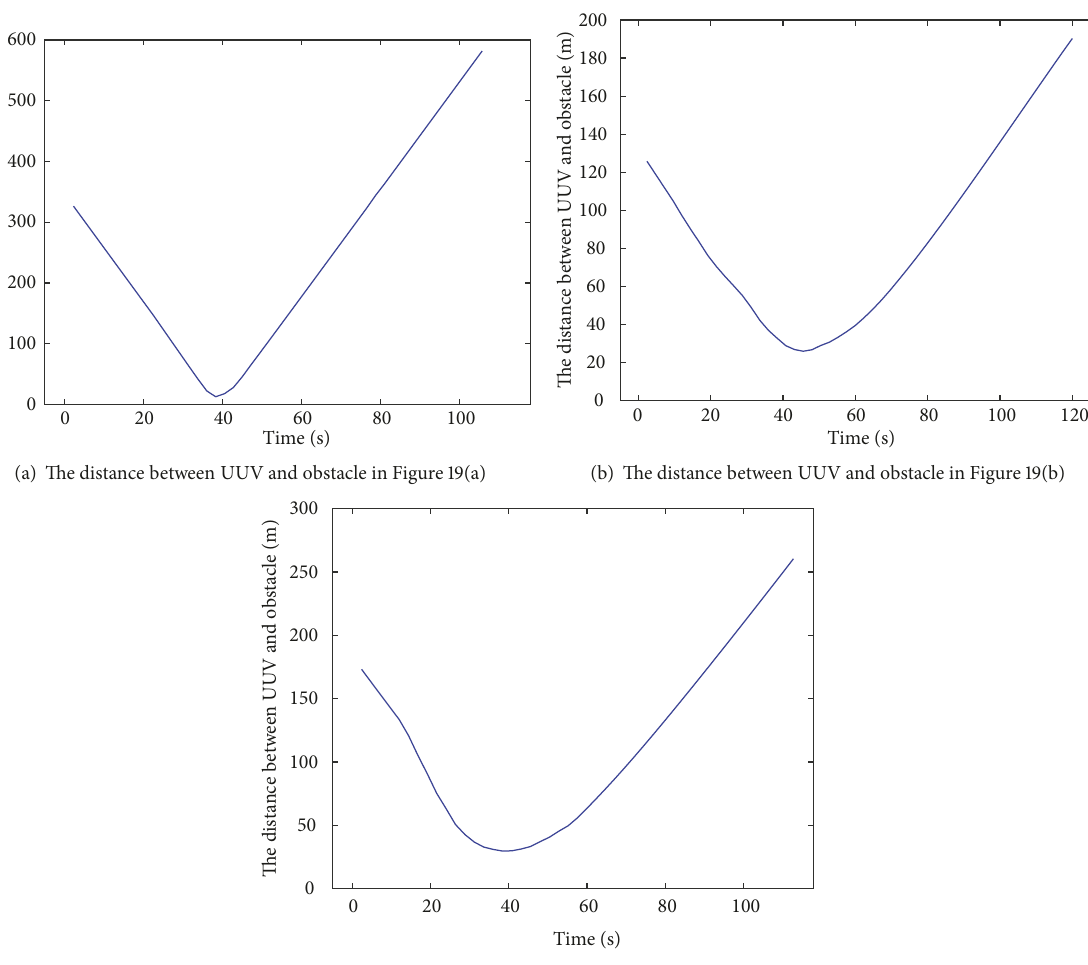
(c) The distance between UUV and obstacle in Figure 19(c) Figure 20: The minimum distance between UUV and obstacle corresponding to Figure